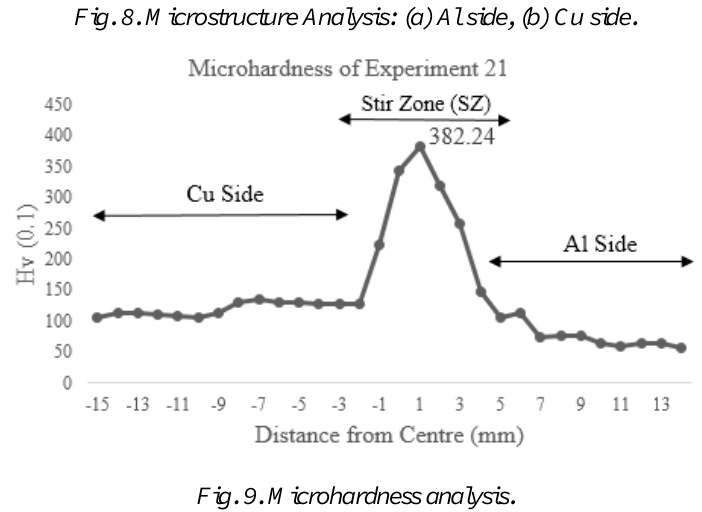
Fig. 9. Microhardness